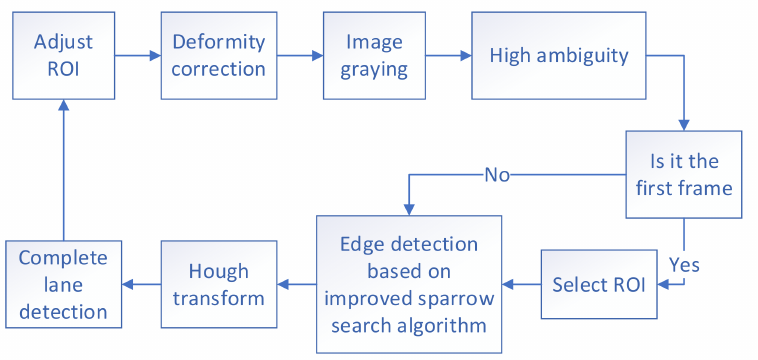
Figure 10. Flow chart of lane detection